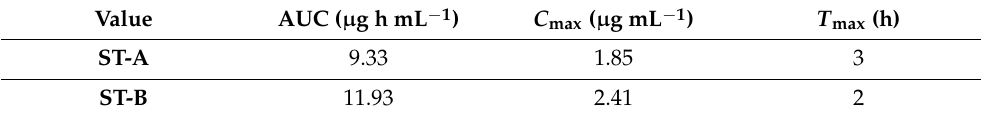
Table 2. Pharmacokinetic parameters of Sor-Tos after a single dose at 27.5 mg kg − 1 via oral